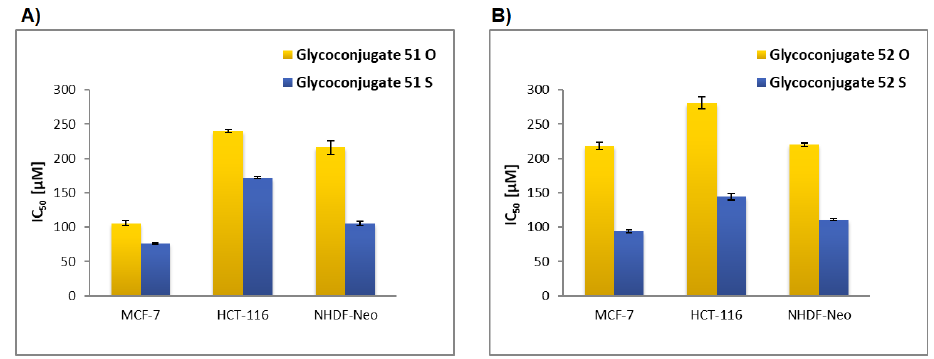
Figure 3. Comparison of IC 50 activity glycoconjugates 51 ( A ) and 52 ( B ) containing sulfur or oxygen atom at the sugar anomeric position.